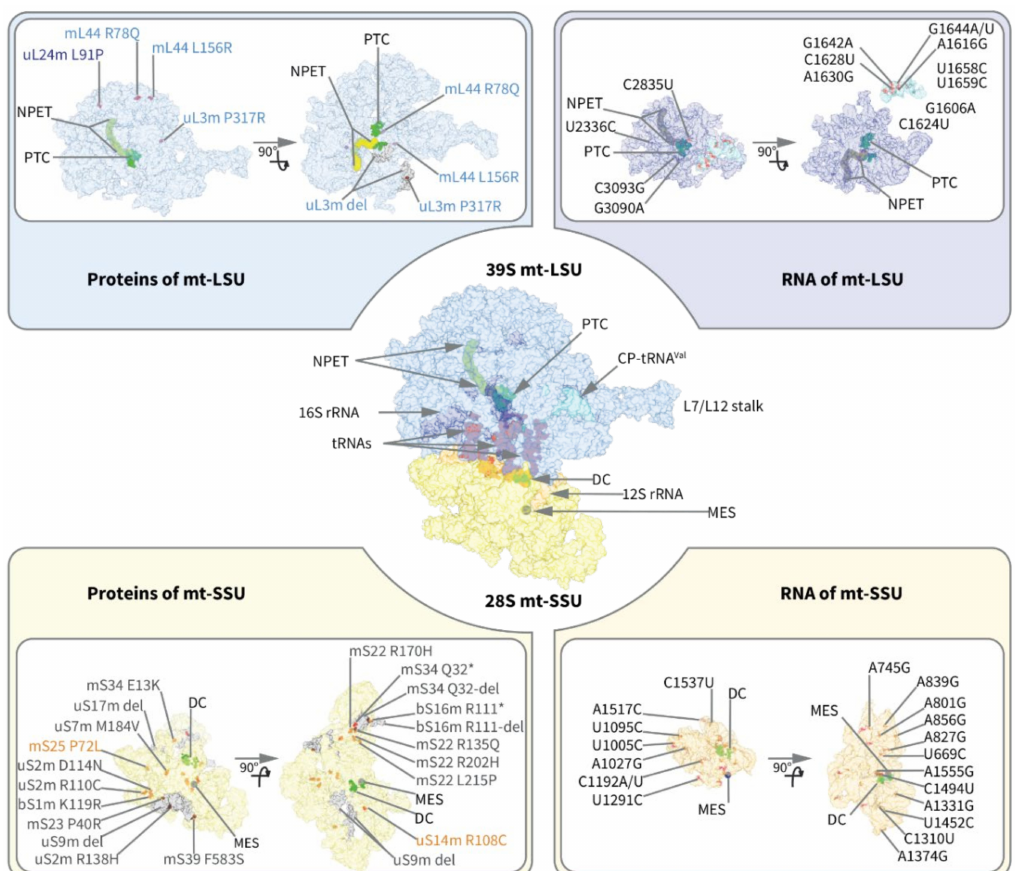
Figure 4. Disease-related mutations mapped on the structure of the human mitoribosome. Human mitochondrial ribosome (central panel). The mt-LSU contains mitoribosomal proteins (light blue), 16S mt-rRNA (blue), and CP-tRNA Val (cyan), whereas the mt-SSU includes mitoribosomal proteins (yellow) and 12S mt-rRNA (orange). A-, P-, and E-site tRNA molecules (light red) bind both subunits of the mitoribosome. Key active sites of the mitoribosome: peptidyl transferase center (PTC) and decoding center (DC) are colored in green. Nascent peptide exit tunnel (NPET) is shown on the mt-LSU in yellow. mRNA entry site (MES) is shown on the mt-SSU in blue. Point mutations (red) or deletions (gray) may occur in both LSU (top) and SSU (bottom), targeting either protein components (left-hand side panel) or RNA (right-hand side panel). The colors of the protein names reflect the assembly stage they are incorporated into mitoribosome, according to the kinetic model (see Figure 2 for details). Each component (proteins or RNA) is shown in two orientations, the same as the original 55S monosome and rotated by 90 ◦ to depict the intersubunit surface. “del” indicates a complete deletion of a protein, while “X-del” notation indicates that residue X becomes a stop-codon and remaining C-terminal part is not present in the protein. Some of the mutations were not mapped since they are not resolved in the structure (see Table 1 for